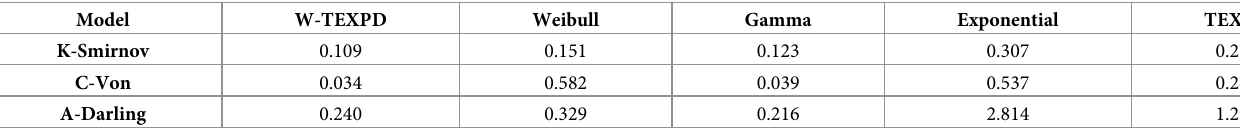
Table 10. Goodness of fit statistic.